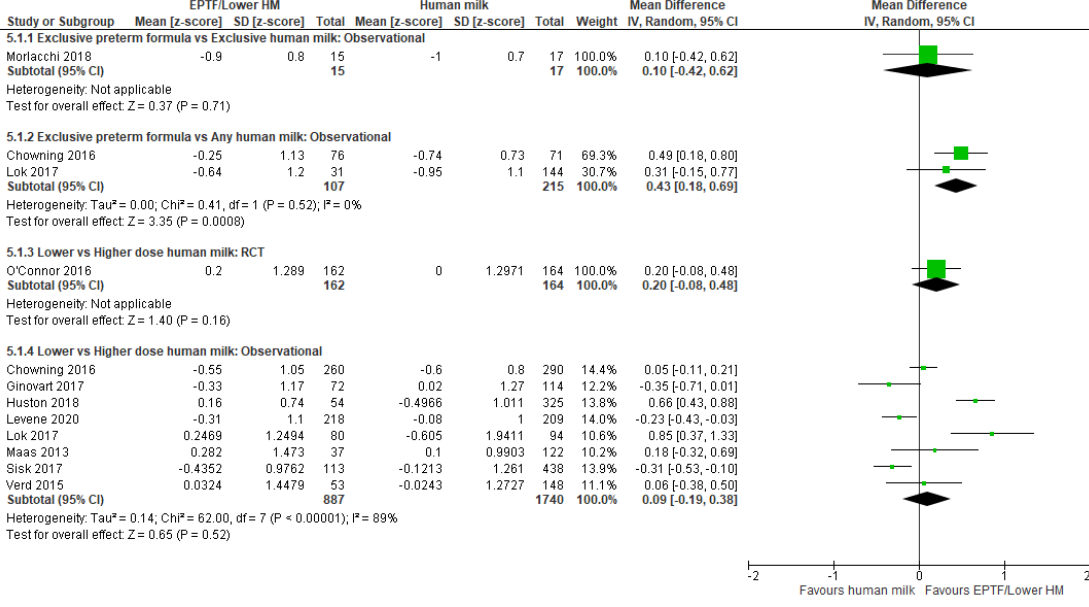
Figure 5. Forest plot of mean difference in change in head circumference z-scores and human milk intake.